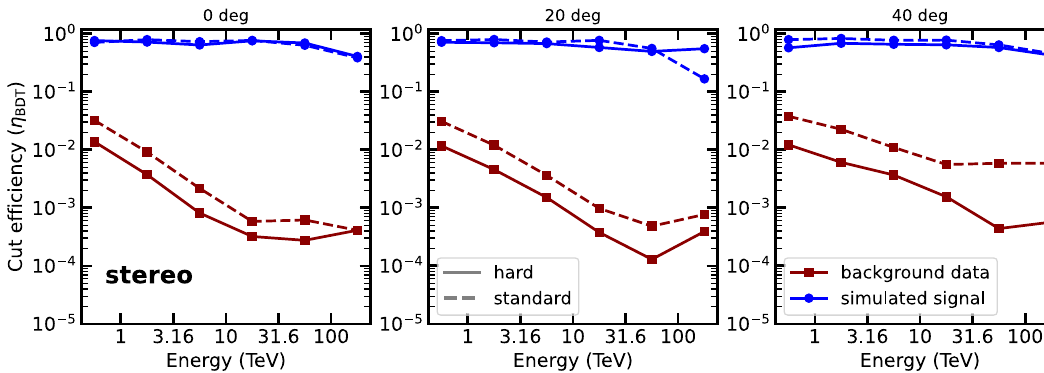
Fig. 6 Cut efficiencies of the stereo reconstruction for the standard and hard cuts